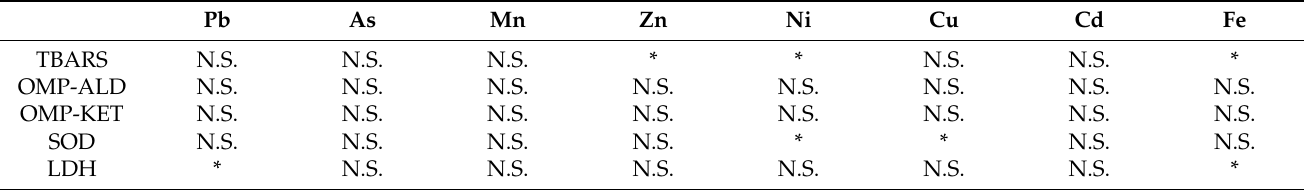
Table 5. Correlations between oxidative stress indicators and trace elements accumulation in the muscle of the lesser spotted dogfish S.canicula . (N.S.—not significant; * p < 0.01). Mn